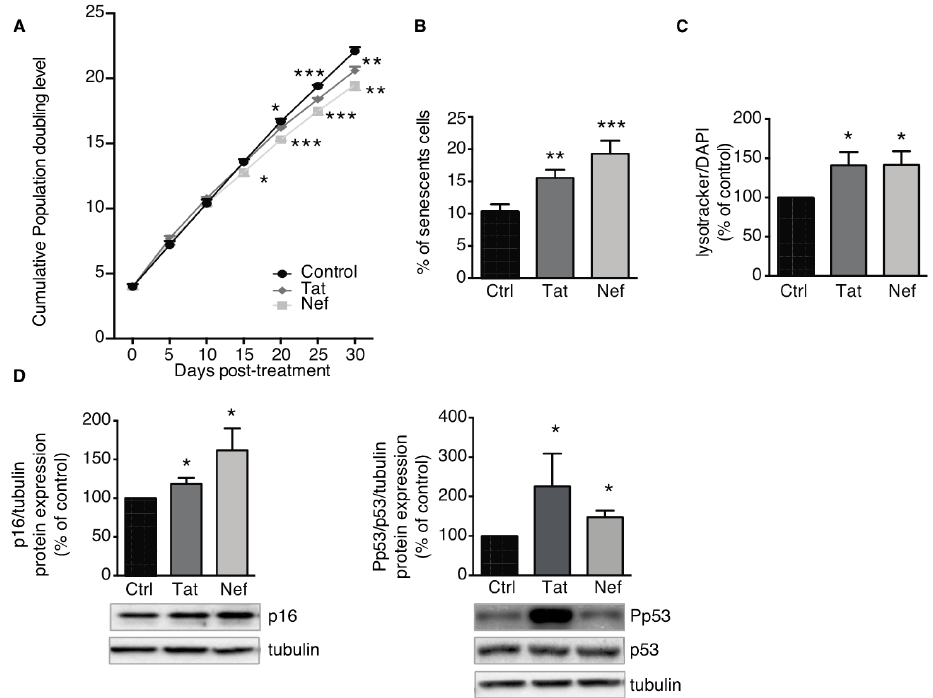
Figure 2. Trans-activator of transcription (Tat) and negative-regulating factor (Nef) proteins induce cell senescence in adipose stem cells (ASCs). ASCs, isolated from different abdominal SCAT healthy donors, were cultured with the HIV proteins Tat or Nef for 30 days. ( A ) Calculation of the cumulative population doubling level (PDL) is described in the Material and Methods Section. Mean ± SEM PDL values were determined on the indicated days of treatment with the HIV proteins ( n = 9, in duplicate). ( B ) After 15 days of treatment with Tat or Nef, senescence was evaluated in terms of SA- β -galactosidase activity at pH 6 and expressed as the number of SA- β -galactosidase-positive cells as a percentage of total cells ( n = 9). ( C ) Lysosomal accumulation was assessed as LysoTracker fluorescence, normalized against DAPI ( n = 9, in duplicate). ( D ) Whole-cell lysates were extracted from ASCs after 15 days of treatment with Tat or Nef, and analyzed by immunoblotting. Representative immunoblots of cell cycle arrest markers p16, phosphorylated-p53, and p53 and tubulin (loading control) are shown ( n = 4). Densitometry analyses against tubulin as loading control were performed for p16 and p53 activation, and expressed as a mean % of the value for control cells ± SEM. * P < 0.05, ** P < 0.01, *** P < 0.001 vs. control cells.